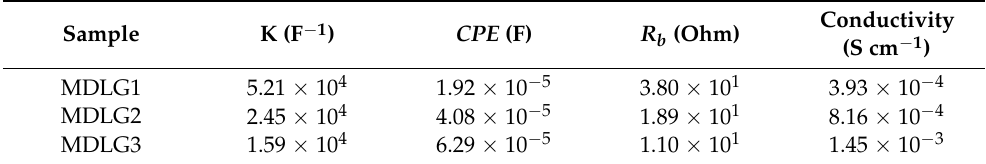
Table 3. EEC fitting parameters for each